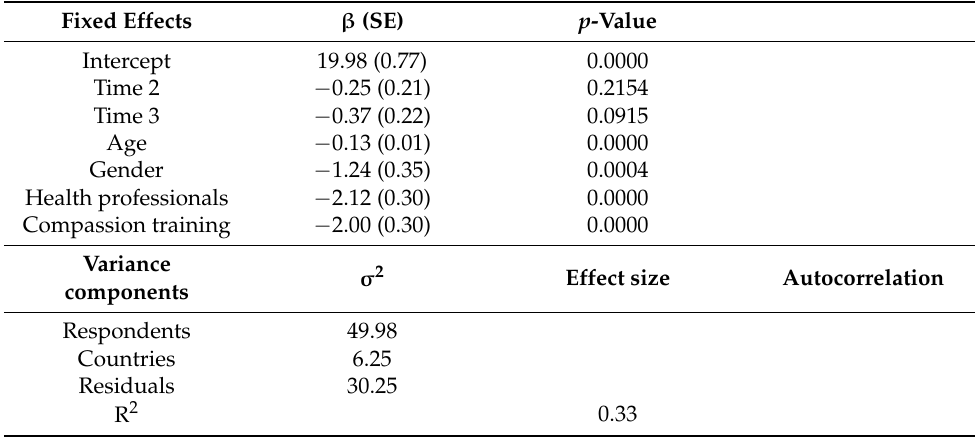
Table 6. Estimates of the final model for fear of compassion for others.